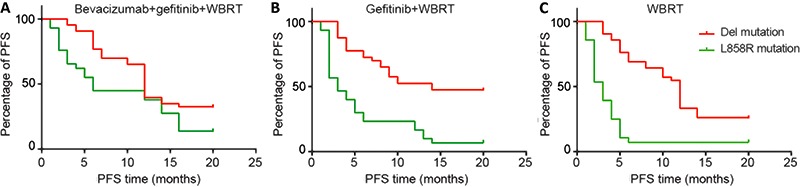
Kaplan-Meier estimation of progression-free survival in patients with brain metastases due to non-small-cell lung cancer with and without EFGR mutations treated with bevacizumab-gefitinib-WBRT, gefitinib-WBRT and WBRT. WBRT: whole brain radiotherapy.